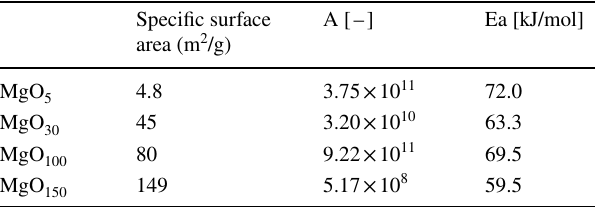
Table 4 Apparent activation energy and the frequency factor of this reaction Specific surface area (m 2 /g)